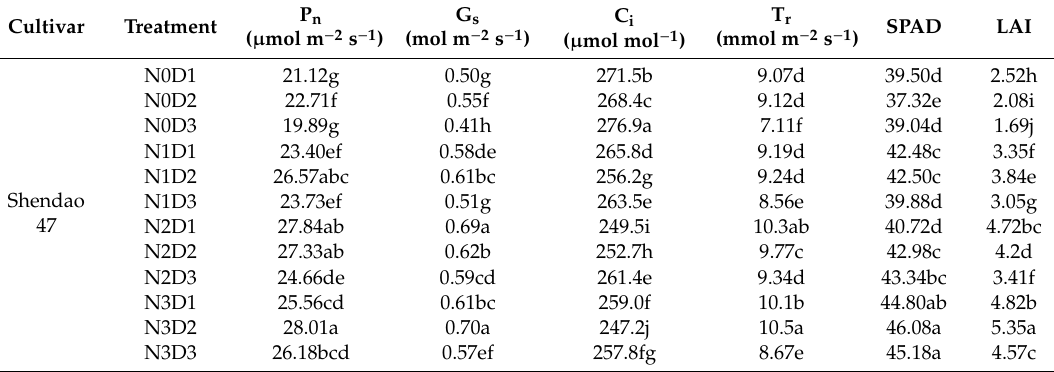
Table 4. Leaf photosynthetic characteristics of three cultivars under di ff erent nitrogen application rates and transplanting